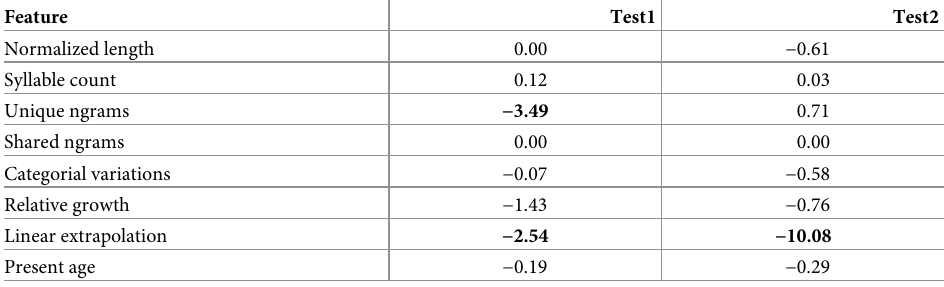
Table 7. The drop in F-score when a feature is removed from the NBCP system. Numbers that are statistically signif- icant with 95% confidence are marked in bold. Negative numbers indicate that a feature is making a useful contribu- tion to the